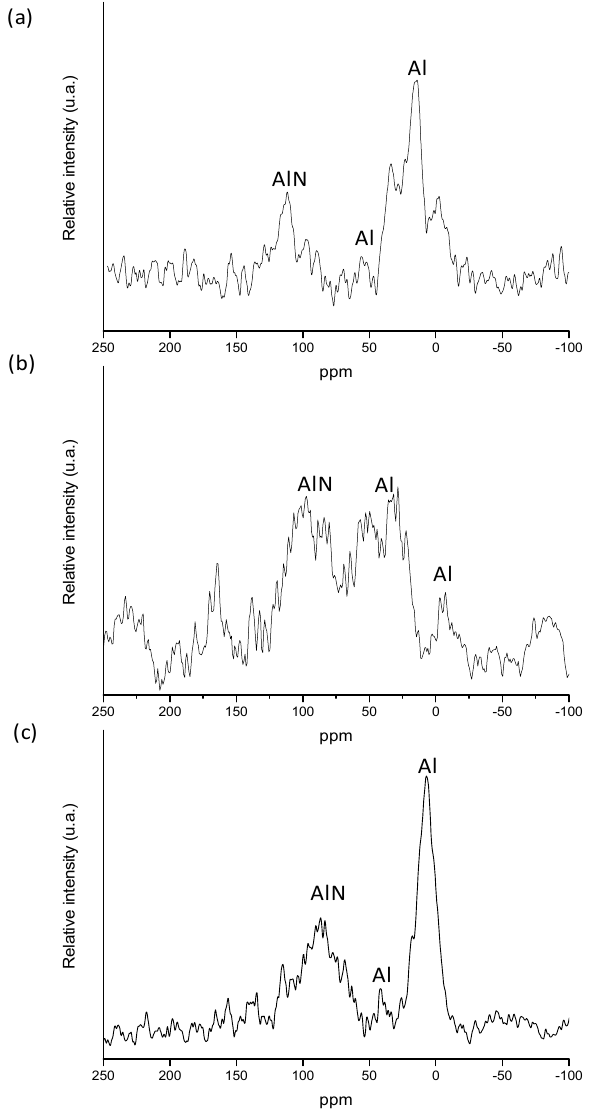
Figure 2. ( a ) 27 Al NMR spectra of Al pure / AlN particles; ( b ) DRX pattern and 27 Al MAS NMR spectra of Al-12Si / AlN particles; ( c ) DRX pattern and 27 Al MAS NMR spectra of AA6061 / AlN particles.